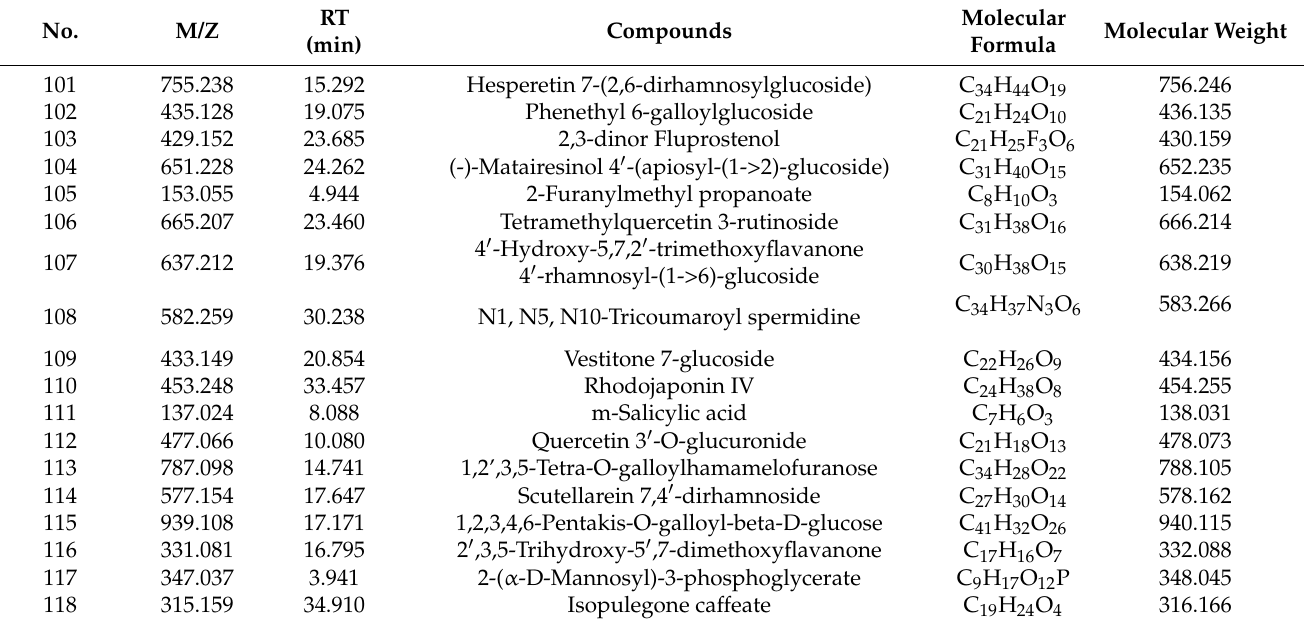
Figure 2. LC-MS chromatogram of ethanolic A. lancea rhizome extract. Table 4. Compounds identified in the ethanolic extract of Prabchompoothaweep remedy by LC- QTOF-MS. No.